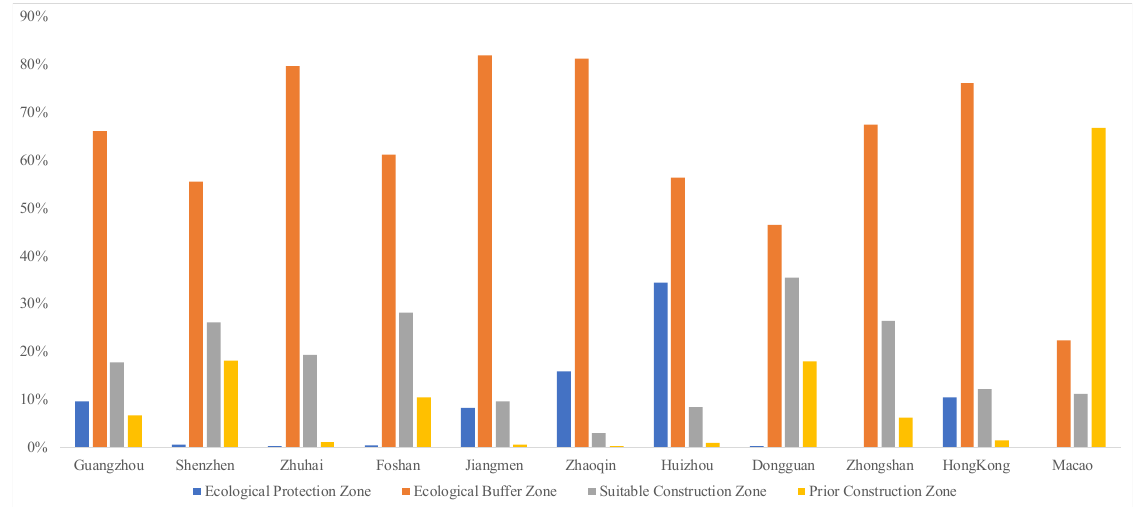
Figure 8. The proportion of LES zoning in 11 cities of the GBA.